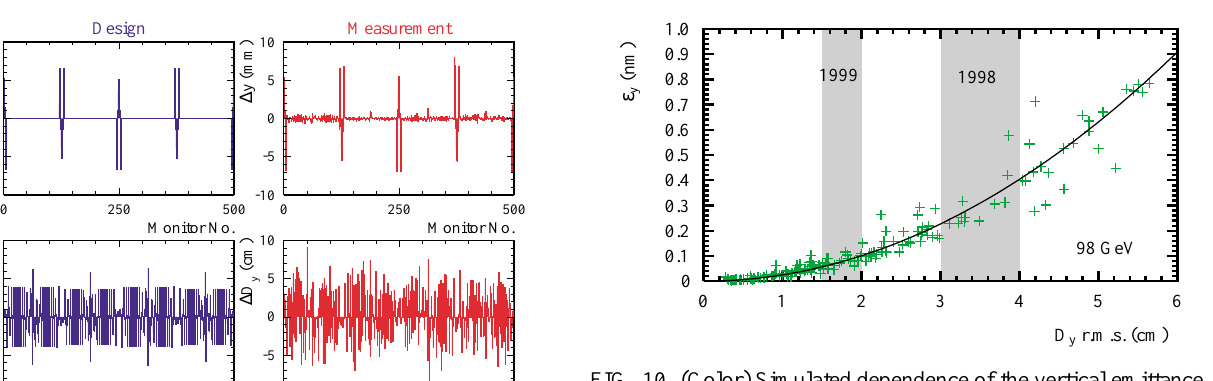
FIG. 10. (Color) Simulated dependence of the vertical emittance ´ y on the rms vertical dispersion. The typical vertical dispersion rms for 1998 and 1999 are indicated by the two